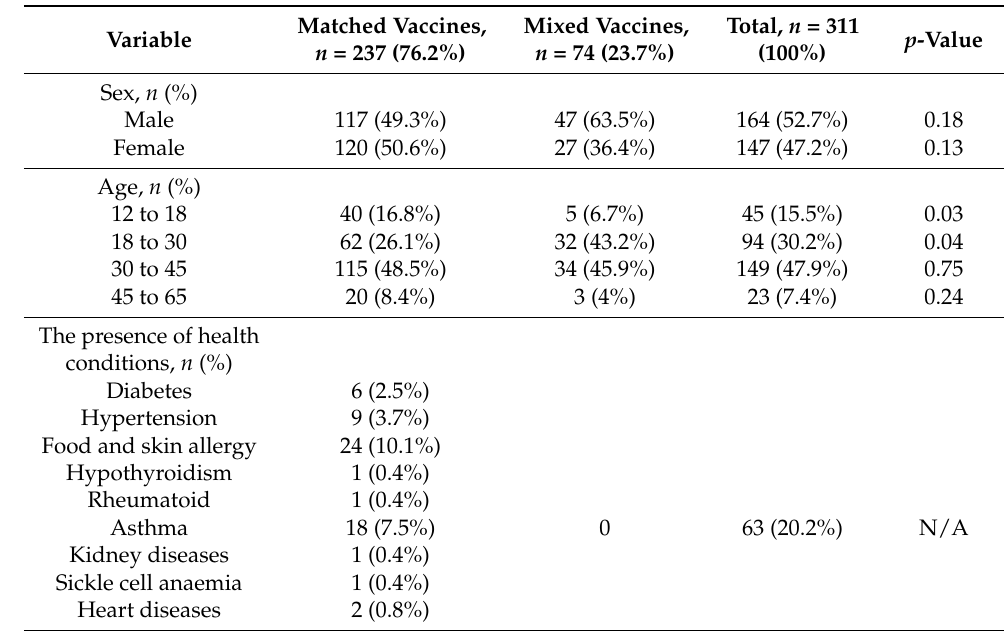
Table 1. Gender, age, and risk factors for COVID-19 infection among participants within this study. This table shows the matched and mixed vaccines, including the first and second doses with either Pfizer–BioNTech or Oxford–AstraZeneca. Data are shown as numbers (percentages). The chi-square test was used to check whether the differences between groups are statistically significant or